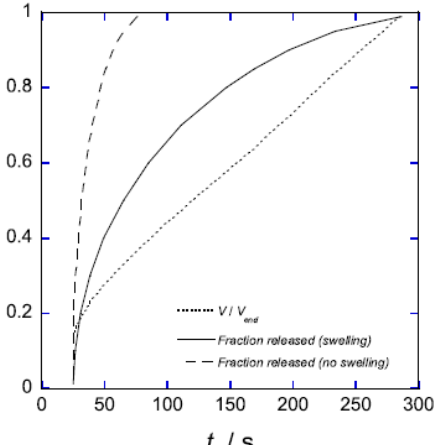
Figure 26. ( a ) Relative microgel volume as a function of time during release of amitriptyline hydrochloride (AMT) for three different microgels of different sizes. Release medium is 150 mM NaCl. V is the actual microgel volume, and V end is the volume after completed release; ( b ) master curve obtained from ( a ) by normalizing time by the square of radius of the respective network in the reference state (R out ), as suggested by theory. Figure adapted from ref. [69]. Used with permission.